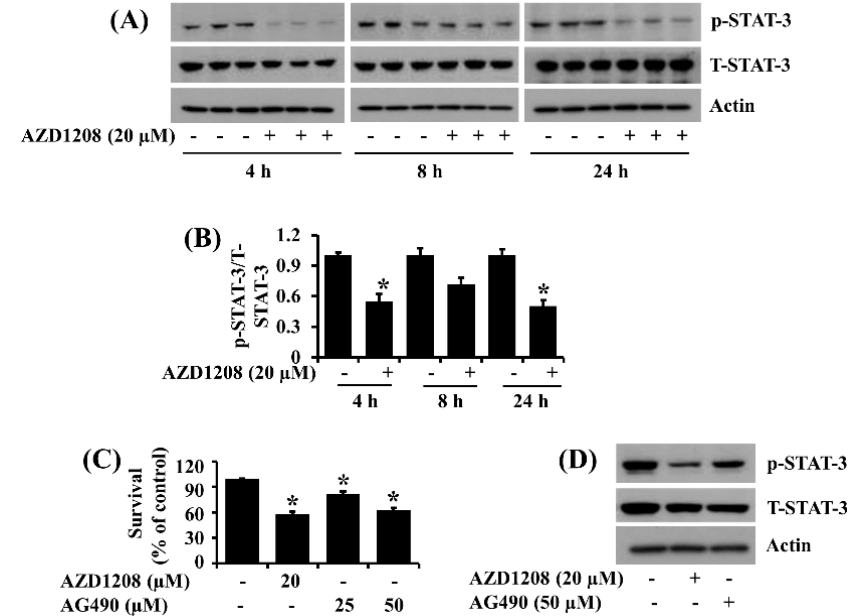
Figure 3. Effect of AZD1208 on expression and phosphorylation levels of STAT-3 in 93T449 cells. ( A ) 93T449 cells were treated with AZD1208 (20 µM) or vehicle control (DMSO) in triplicate